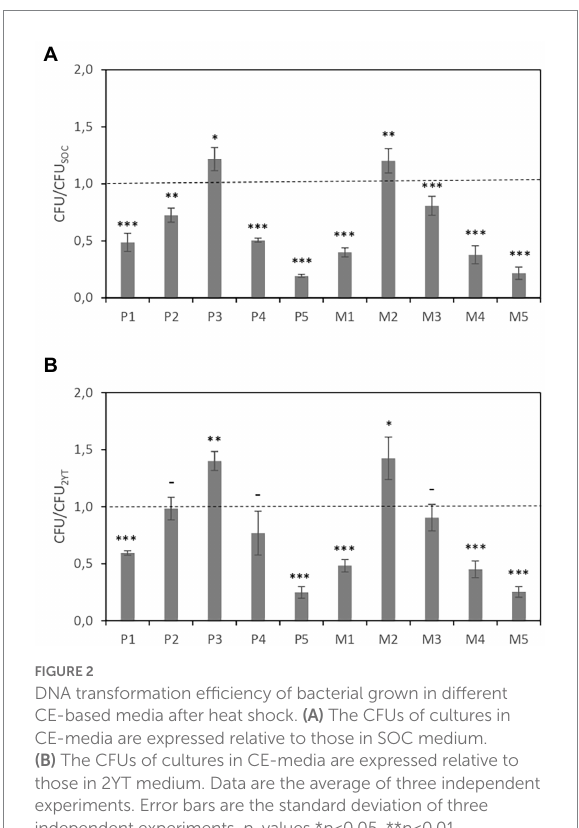
FIGURE 2 DNA transformation efficiency of bacterial grown in different CE-based media after heat shock. (A) The CFUs of cultures in CE-media are expressed relative to those in SOC medium. (B) The CFUs of cultures in CE-media are expressed relative to those in 2YT medium. Data are the average of three independent experiments. Error bars are the standard deviation of three independent experiments. p -values * p < 0.05, ** p < 0.01, *** p < 0.001, and – p ≥ 0.05.